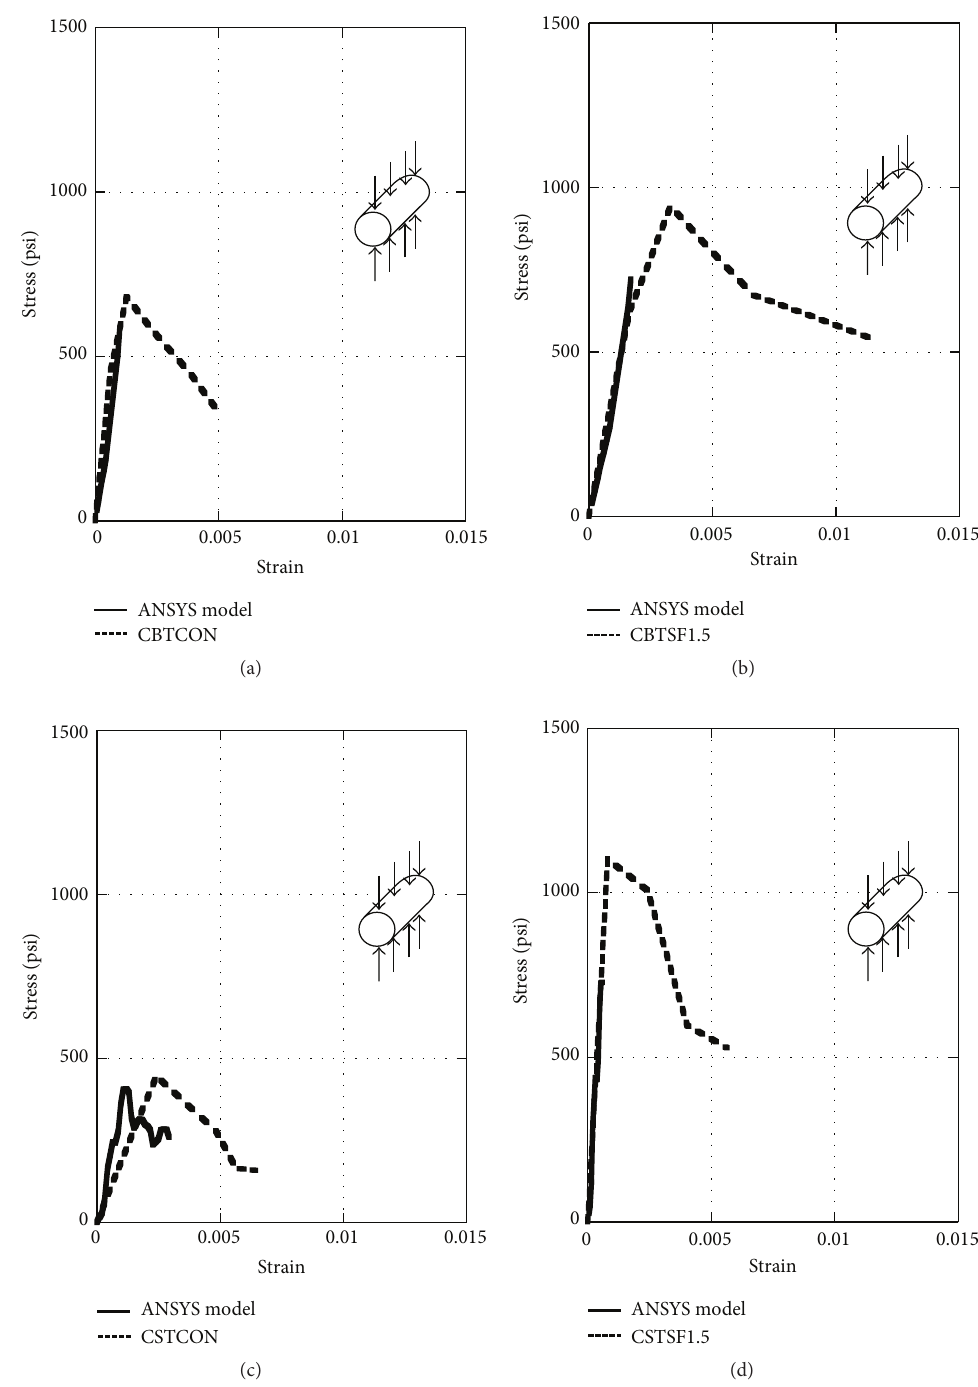
Figure 8: Evaluation of tensile stress-strain behavior from experimental tests and FE analyses: (a) brick concrete, (b) brick SFRC, (c) stone concrete, and (d) stone